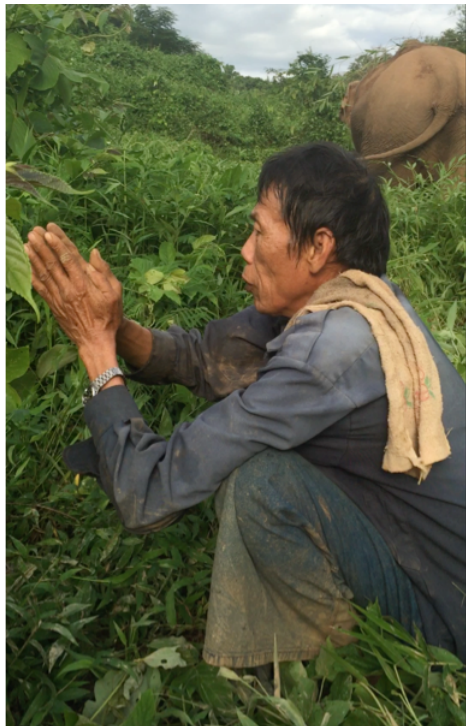
Figure 1. A mahout praying to a forest divinity to ask for protection of his elephant before releasing him in the forest. Source: Lainé